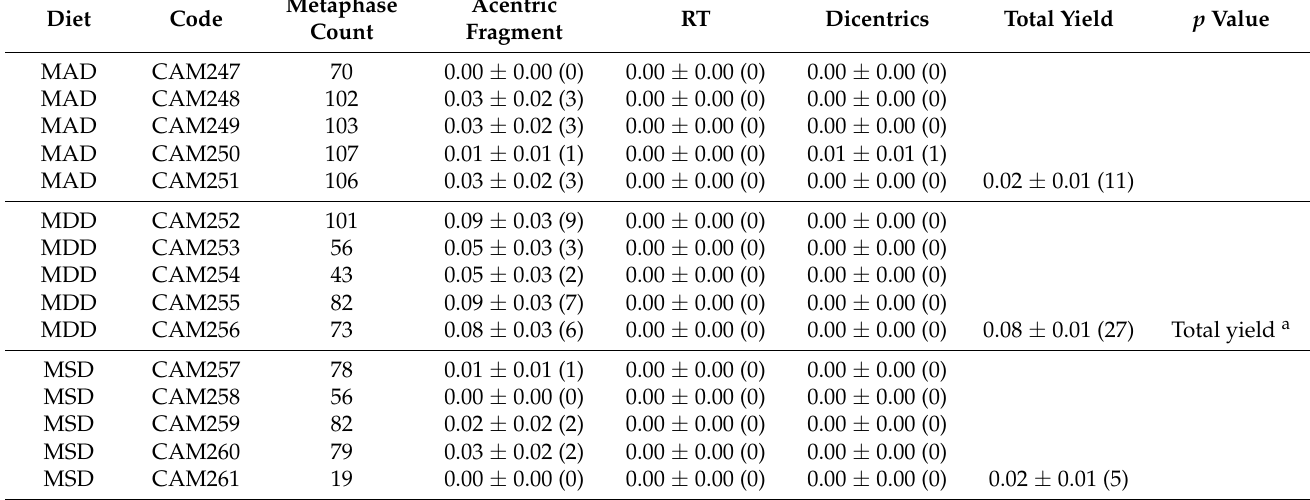
Table 3. Distribution of aberration frequencies ± standard errors (number of aberrations observed) detected by solid Giemsa staining in the bone marrow cells of CBA/J mice fed with either methionine-deficient, MDD (0%), methionine-adequate, MAD (100%), or methionine-supplemented, MSD (300%) diets for 2 months. a, statistically significant difference in total yield from